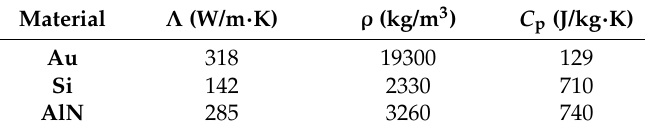
Figure 3. Finite element model of the Au nano-strip, AlN thin film and Si substrate.